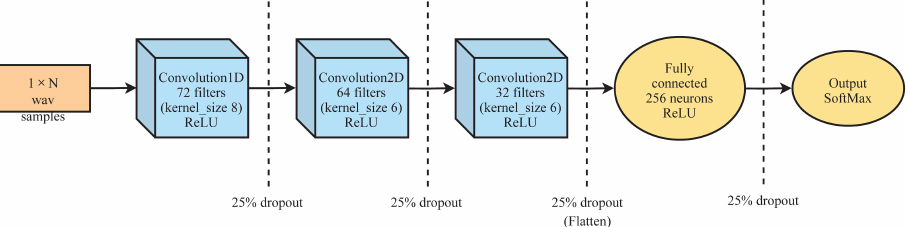
Figure 6. The proposed CNN